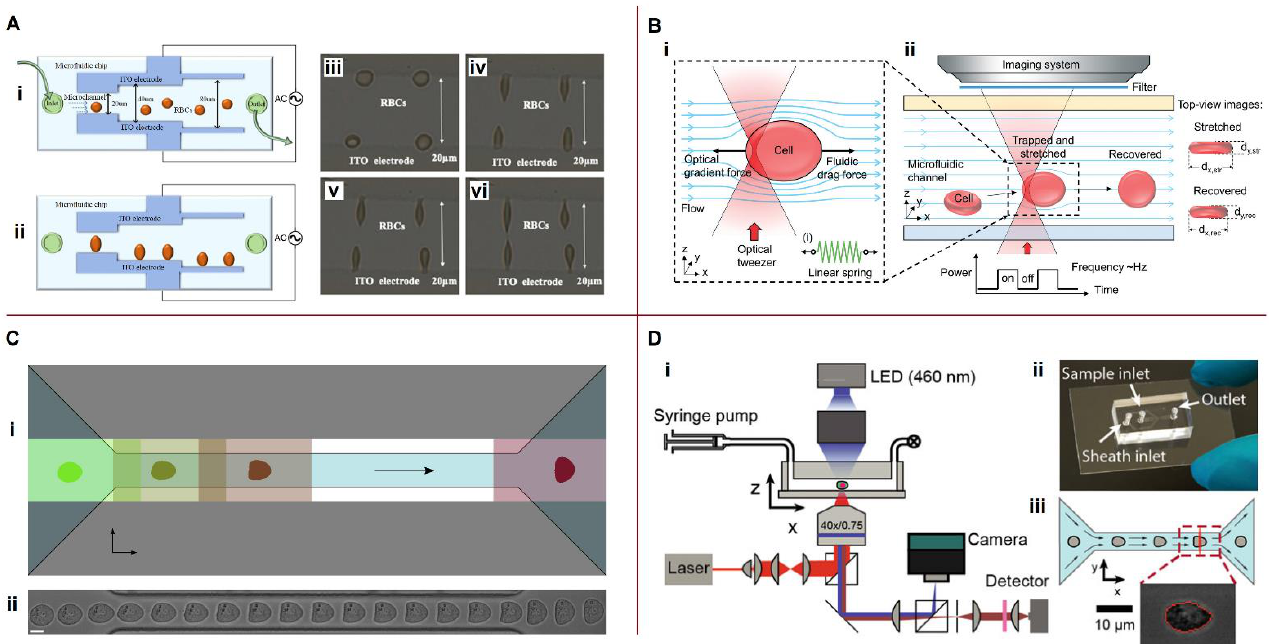
Figure 9. Microfluidic platforms for measuring the mechanical properties of blood cells. ( A ) Deformation of RBCs between parallel ladder electrodes under different voltages: ( i ) RBCs fill the microchannel. ( ii ) RBCs deformed under constant DEP stress. ( iii ) RBCs captured and then deformed under: ( iv ) 2 V pp , ( v ) 4 V pp , and ( vi ) 6 V pp . Reproduced with permission from [157]. Copyright 2019, Springer-Verlag London Ltd., part of Springer Nature. ( B ) Optofluidic “tweeze-and-drag” cell stretcher: ( i ) Working principle diagram. Inset: a linear spring model of a cell under a stretching force. ( ii ) Top view of stretched and reconstructed cells and their x- and y-dimensions. Reproduced with permission from [158]. Copyright 2020, The Royal Society of Chemistry. ( C ) Dynamic real-time deformability cytometry (dRT-DC): ( i ) Experimental setup and region of interest at selected time points t 1 , t 2 , t 3 , and t n . ( ii ) Time series of a cell moving along a channel (30 × 30 μm cross section, 300 μm length). Reproduced with permission from [159]. Copyright 2019, the author(s). ( D ) Real-time fluorescence and deformability cytometry (RT-FDC): ( i ) Experimental setup. ( ii ) Photographic image of a PDMS microfluidic chip. ( iii ) Representative image of a cell passing through a narrow constriction. Reproduced with permission from [160]. Copyright 2019, Springer Science + Business Media, LLC, part of Springer